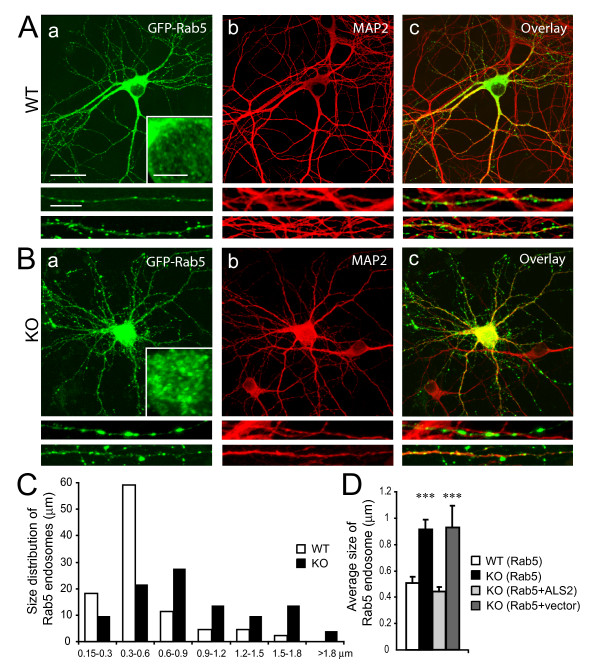
Increased accumulation of enlarged Rab5-associated endosomes in ALS2-/- hippocampal neurons. A-B. Representative images of wild-type (WT; A) and ALS2-/- (KO; B) hippocampal neurons transfected with GFP-Rab5 (a, green) and counterstained with an antibody against MAP2 (b, red). Fragments of soma (inset), axon (middle panel) and dendrite (bottom panel) were enlarged to reveal the distribution and morphology of Rab5-positive vesicles. Panel 'c' is an overlay. Scale bar: 20 μm (main) and 5 μm (inset, middle and bottom panels). C. Histogram reveals the distribution of Rab5-associated vesicles within each size category in WT and KO neurons (n = 5). D. Histogram reveals the average size of Rab5-associated vesicles (n > 45) in wild-type (WT (Rab5)), ALS2-/- (KO (Rab5)), ALS2-transfected ALS2-/- (KO (Rab5+ALS2)) and DsRed-transfecetd ALS2-/- (KO (Rab5+vector)) neurons. Error bars represent SEM. *** P < 0.001.